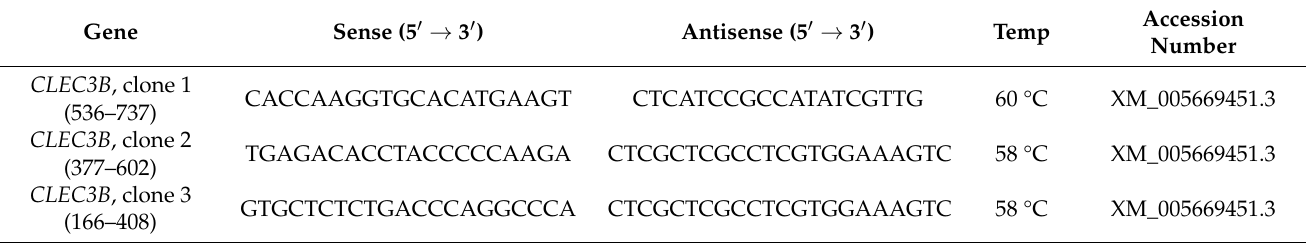
Table 1. List of primers for cloning coding sequence (CDS) of porcine gene CLEC3B (tetranectin, TN) from porcine cDNA library.